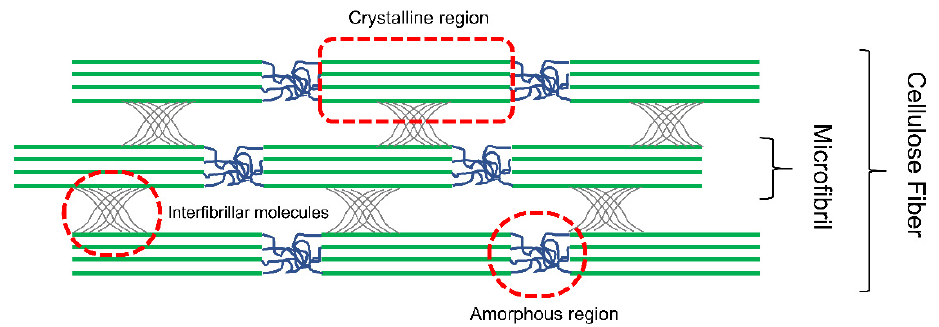
Figure 3. Crystalline and amorphous regions of cellulose as well as the interfibrillar network among cellulose molecules.